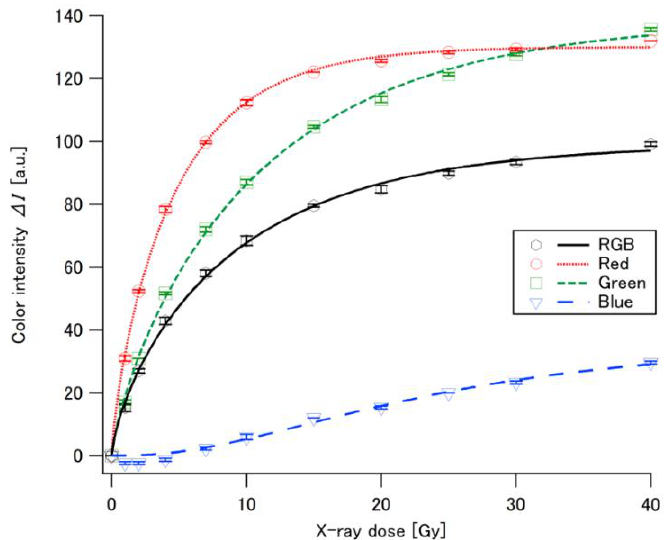
Figure 3. Dose dependences of the color intensities of EBT-XD irradiated with 160 kV X-rays at up to 40 Gy as to RGB, red, green and blue components measured with Nix at the angle of 0°.